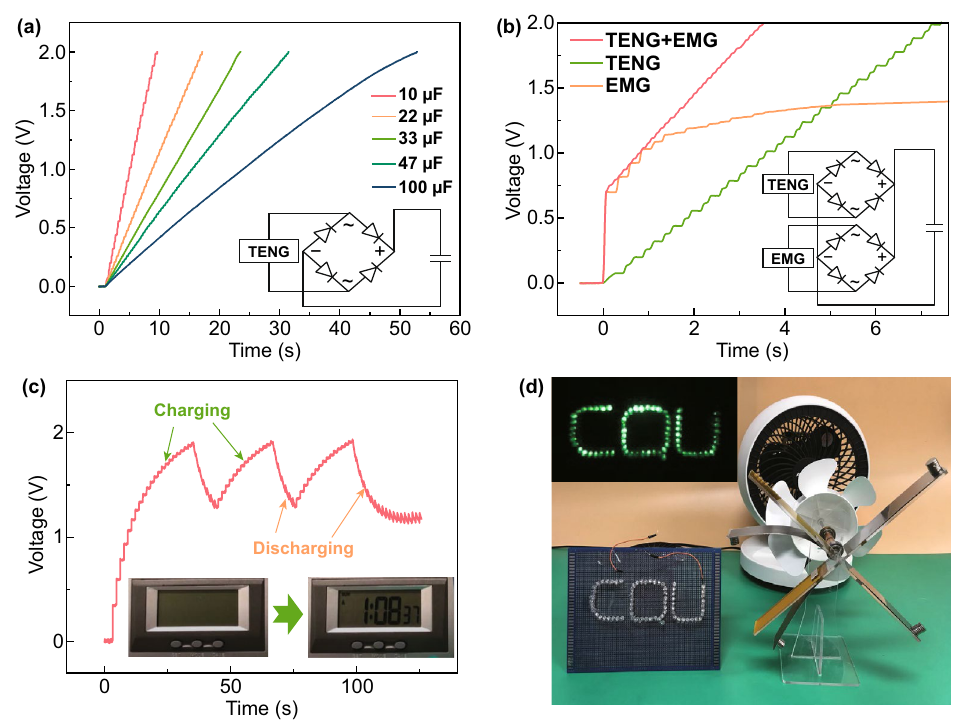
Fig. 5 Applications of the W-HNG. a Voltage curves of several commercial capacitors charged by the TENG harvester at a wind speed of 4.8 m s −1 , and inset is the charging circuit diagram. b Charging curves of a 10 μF capacitor using TENG only, EMGs, and the hybrid nanogen- erator, and the inset is the rectifier circuit diagram. c Charging voltage profile of a 100 μF capacitor for several consequent working cycles of a digital watch at a wind speed of 1.8 m s −1 . d Photograph of W-HNG acting as the power source for lighting